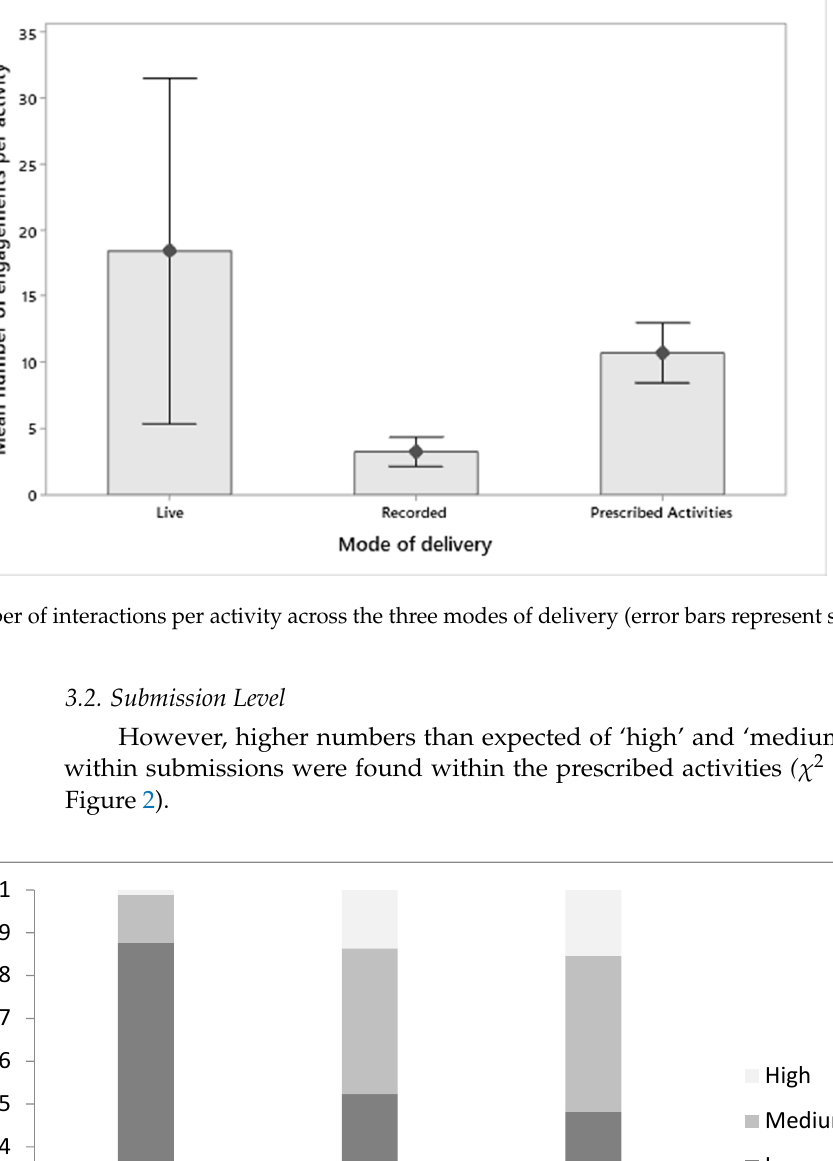
Figure 2. Proportion of submissions by activity type and coded level of complexity (low/medium and high).